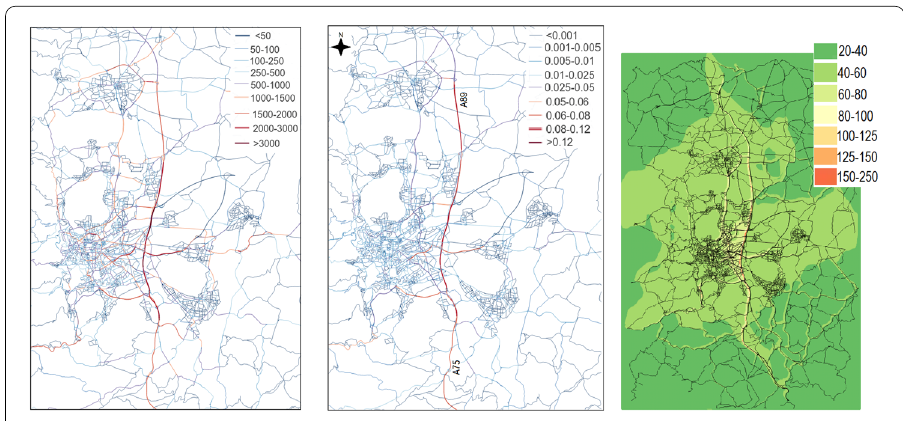
Fig. 2 Simulations over Clermont-Ferrand on 18/11/2014 at 8 a.m. Traffic flow in veh/h/link (left), NO 2 emissions in gkm − 1 s − 1 (center), NO 2 concentration µ gm − 3 (right). A75 and A89 are large highways in the